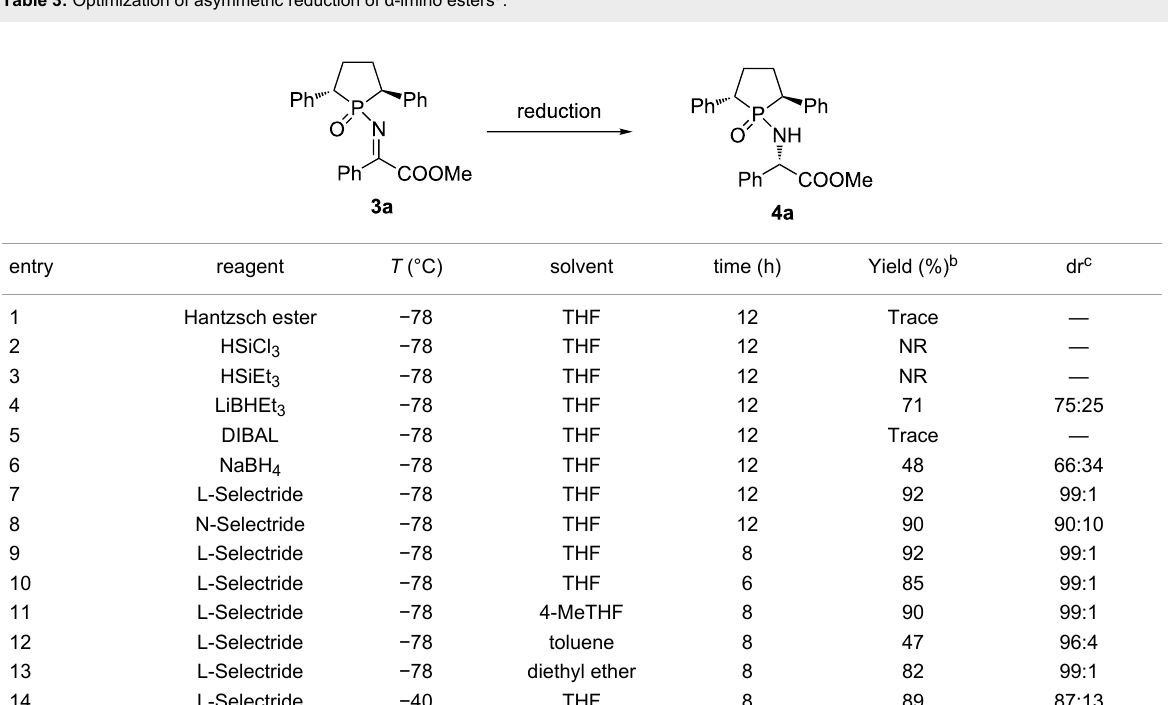
Table 3: Optimization of asymmetric reduction of α -imino esters a